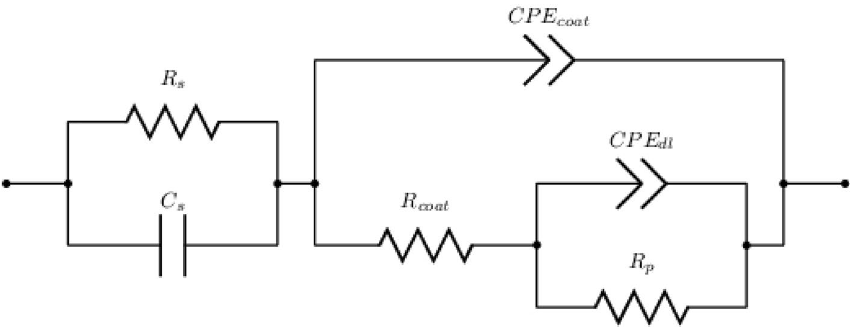
Figure 18. Equivalent electrical circuits used in order to modeling the data measured in the EIS diagram for coated samples.